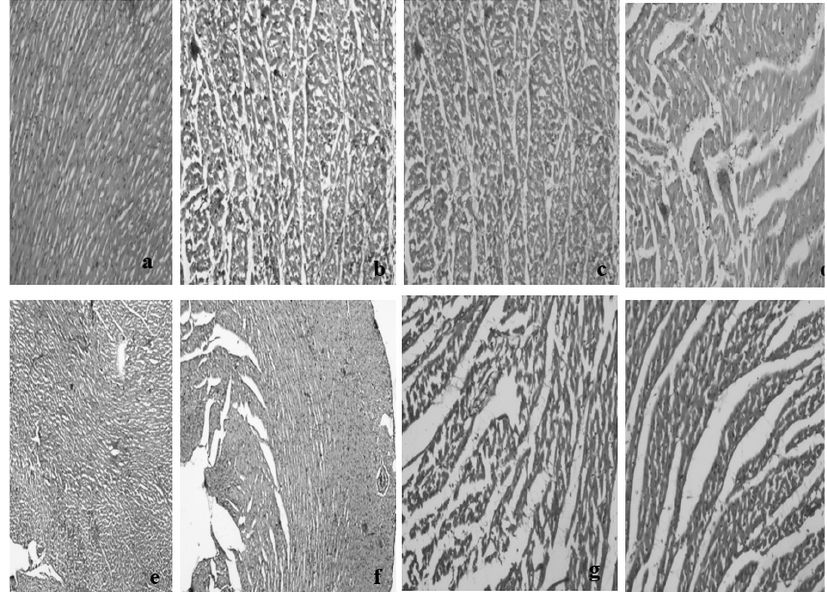
FIGURE 7 - Effect of I/R on histopathological report of heart, effect of IPTC on histopathological change in normal and OVX